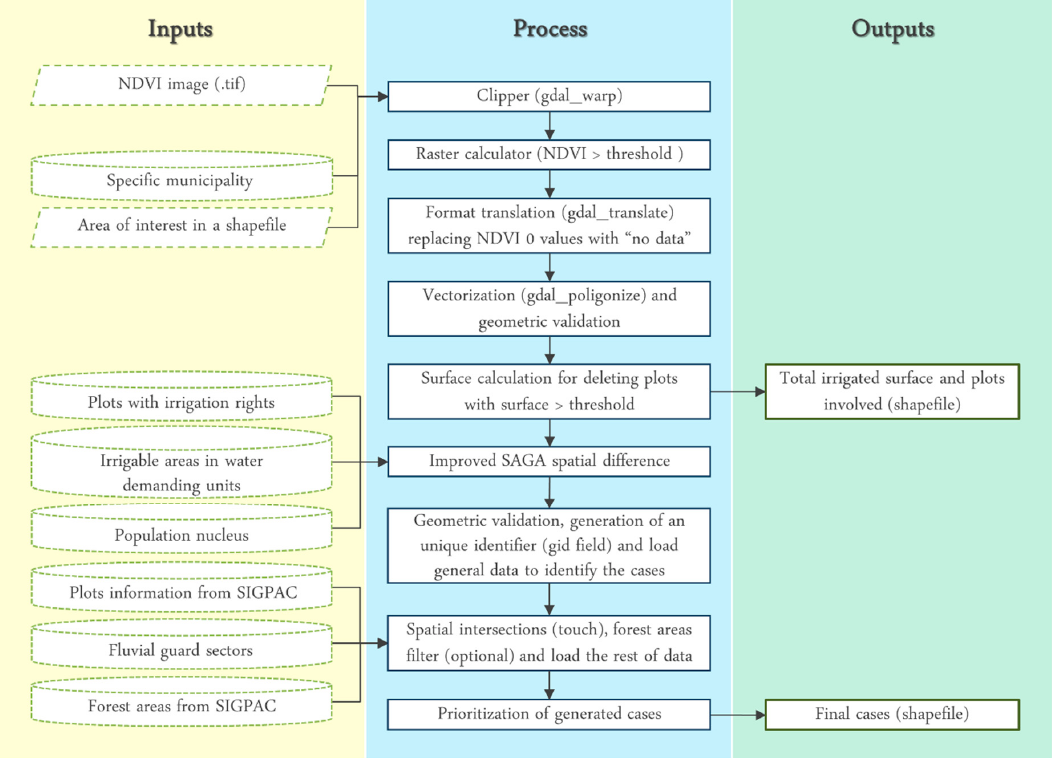
Figure 4. Main flowchart of the proposed methodology for estimating agricultural plots with non-regulated irrigation activity and irrigated surface and plots involved in an area of interest (yellow background: inputs; blue background: flux or process; green background: outputs).